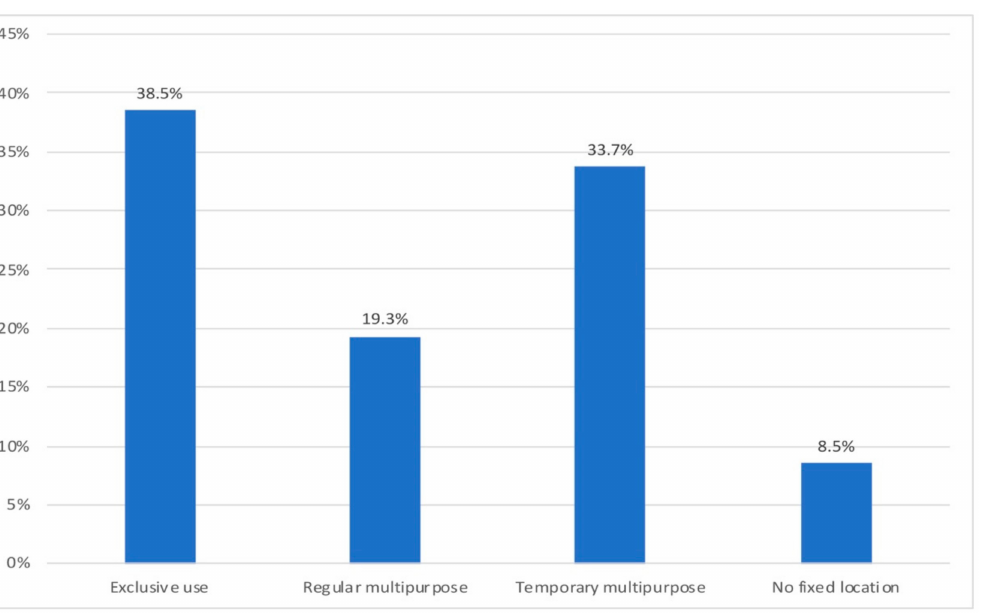
Figure 3. Availability of a usual space for